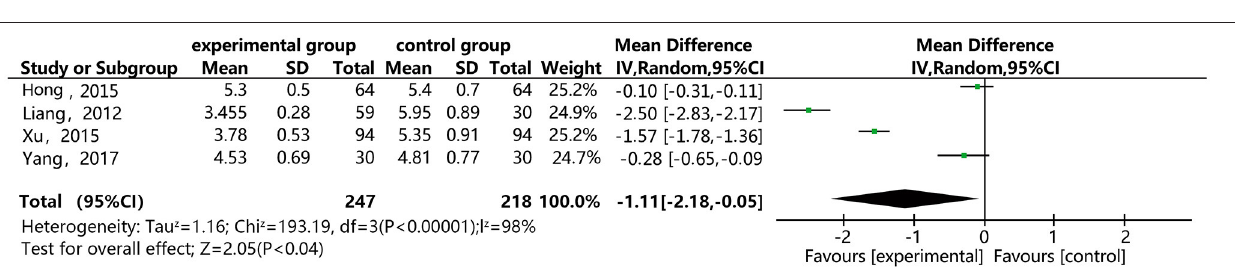
gastrointestinal reactions. Thus, its efficacy has been